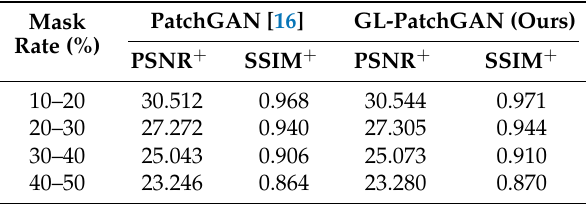
Table 3. Comparison of results of PatchGAN and our GL-PatchGAN discriminators for different